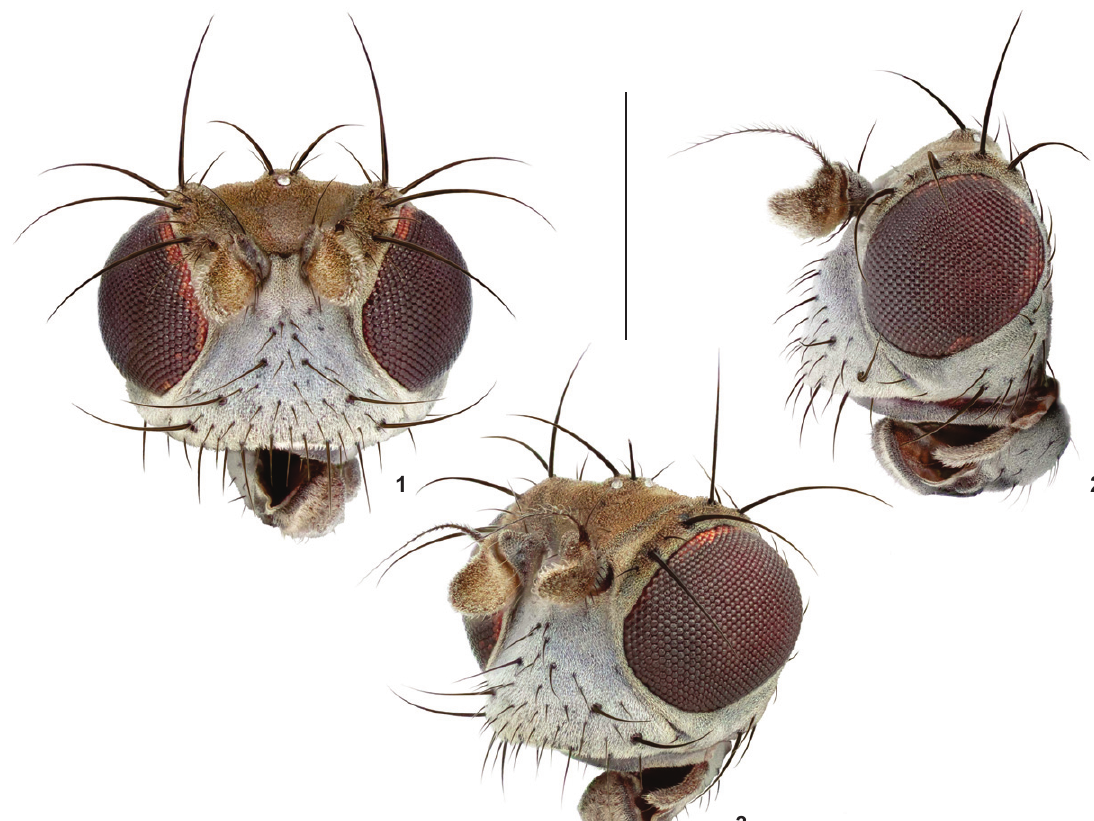
Figures 1-3. Scatella ( Neoscatella ) praia sp. nov. , Brazil, Paraná: Antonina: (1) head, anterior view; (2) same, lateral view; (3) same, oblique view. Scale bar: 0.5